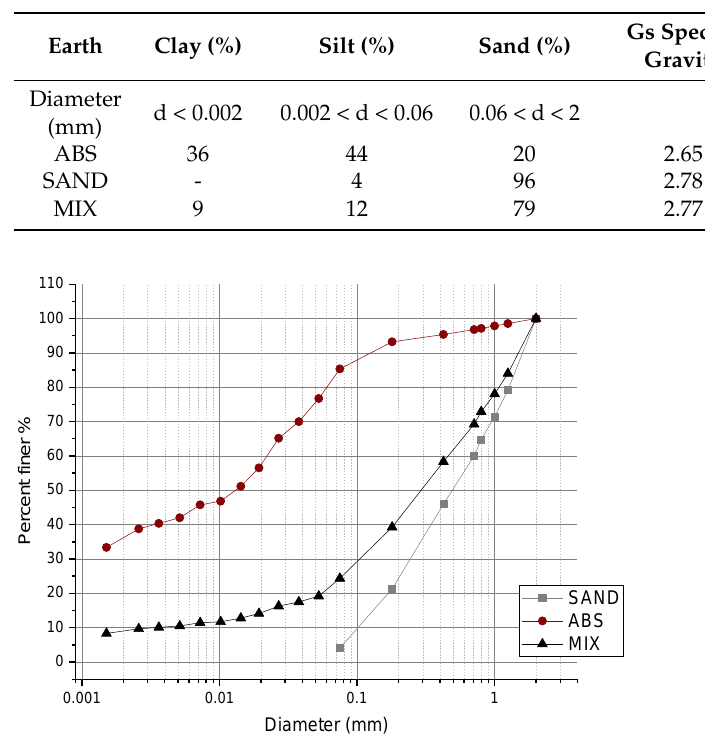
Figure 1. Grain size distribution: soil (ABS), SAND, and MIX (1:3 soil-to-sand ratio) [20]. Copyright 2021 Scientific.Net.